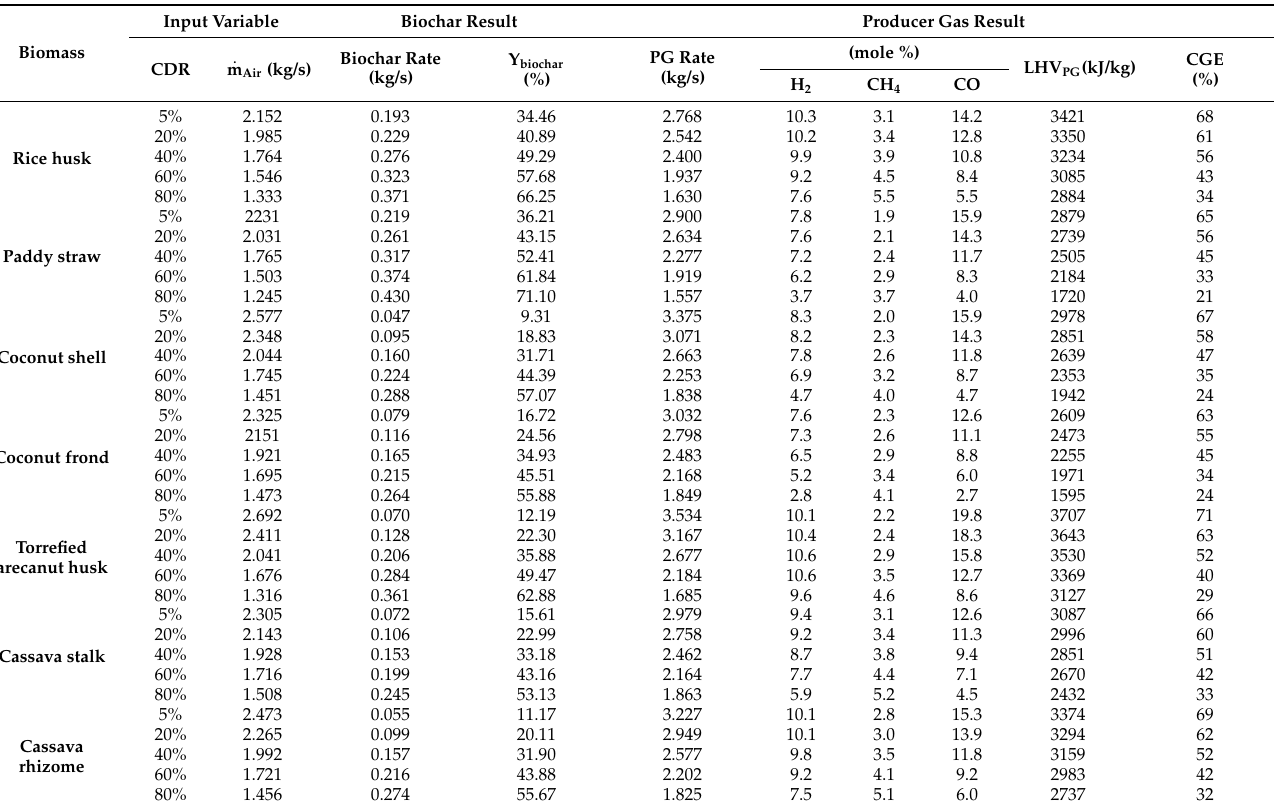
Table 3. Parametric study result for two-reactor models.